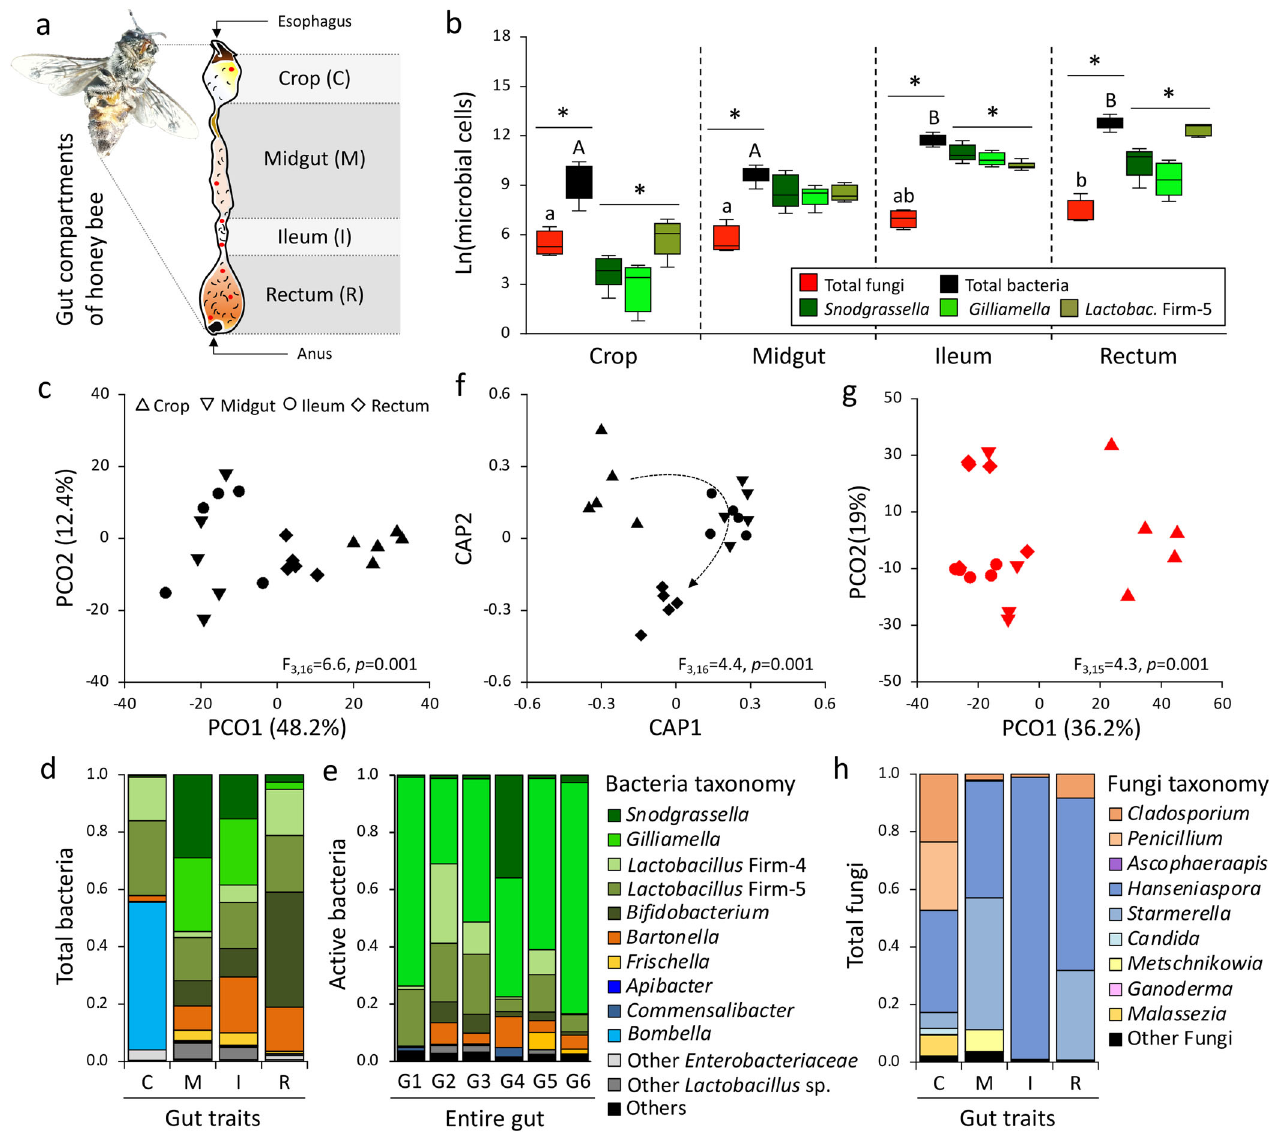
Fig. 2 Bacterial and fungal microbiota of the gut compartments in honeybees. a Schematic representation of honeybee gut compartments (the crop, midgut, ileum, and rectum). Red circles and black rods indicate the relative distribution of total fungi and bacteria, respectively. b The abundance of the bacterial (black bars) and fungal (red bars) members in the honeybee gut compartments are indicated as ln- transformed number of bacterial cells (number of 16S rRNA gene copies measured are normalized for the number of 16S rRNA genes in a bacterial community, n = 4.7) and fungal cells (number of measured internal transcribed spacer [ITS] copies are normalized for the number of ITSs in a fungal community, n = 75.5). Signi fi cant differences among the bacterial and fungal cell abundance along gut tracts are indicated with capital and lower-case letters, respectively (Tukey ’ s multiple comparison test, p < 0.05), whereas the comparison among bacteria and fungi in each trait is indicated by an asterisk (*; t -test, p < 0.05). Abundance (ln-transformed) of Snodgrassella , Lactobacillus Firm-5, and Gilliamella in the different gut compartments are represented by shades of green and are expressed as the number of bacterial cells (number of 16S rRNA gene copies measured are normalized for the number of 16S rRNA gene in these phylotypes, n = 4). Signi fi cant differences among the above-mentioned bacterial species for each gut tract are indicated by an asterisk (*; ANOVA, p < 0.05). All the results are expressed per organ. Principal coordinates analysis (PCoA) showing the ( c ) bacterial and ( g ) fungal communities per each gut compartment, respectively. f Beta-diversity analysis of the other potential environmental bacteria portion. Samples were distributed following a “ horseshoe shape ” ordination (indicated by the arrow) in the space of the canonical analysis of principal coordinates (CAP). d , e Taxonomic af fi liation of total (DNA) and active (cDNA) bacterial communities inhabiting the honeybee gut, respectively, along with ( h ) one for fungal communities (DNA). Abundance of bacterial taxa obtained from DNA are expressed as the number of reads normalized for the mean number of bacterial 16S rRNA genes and fungal ITSs available for each genus/class, respectively (for details, see “ Material and methods ” ). b – d , f – h are referred to the gut compartments ’ pools (each pool, n = 10) originating from Italian A. mellifera ligustica forager bees, whereas e is referred to the entire gut of Saudi Arabian A. mellifera jemenitica ( n = 6). Compartmentalization of bacterial and fungal communities associated with Saudi Arabian forager bees is reported in Supplementary Fig.